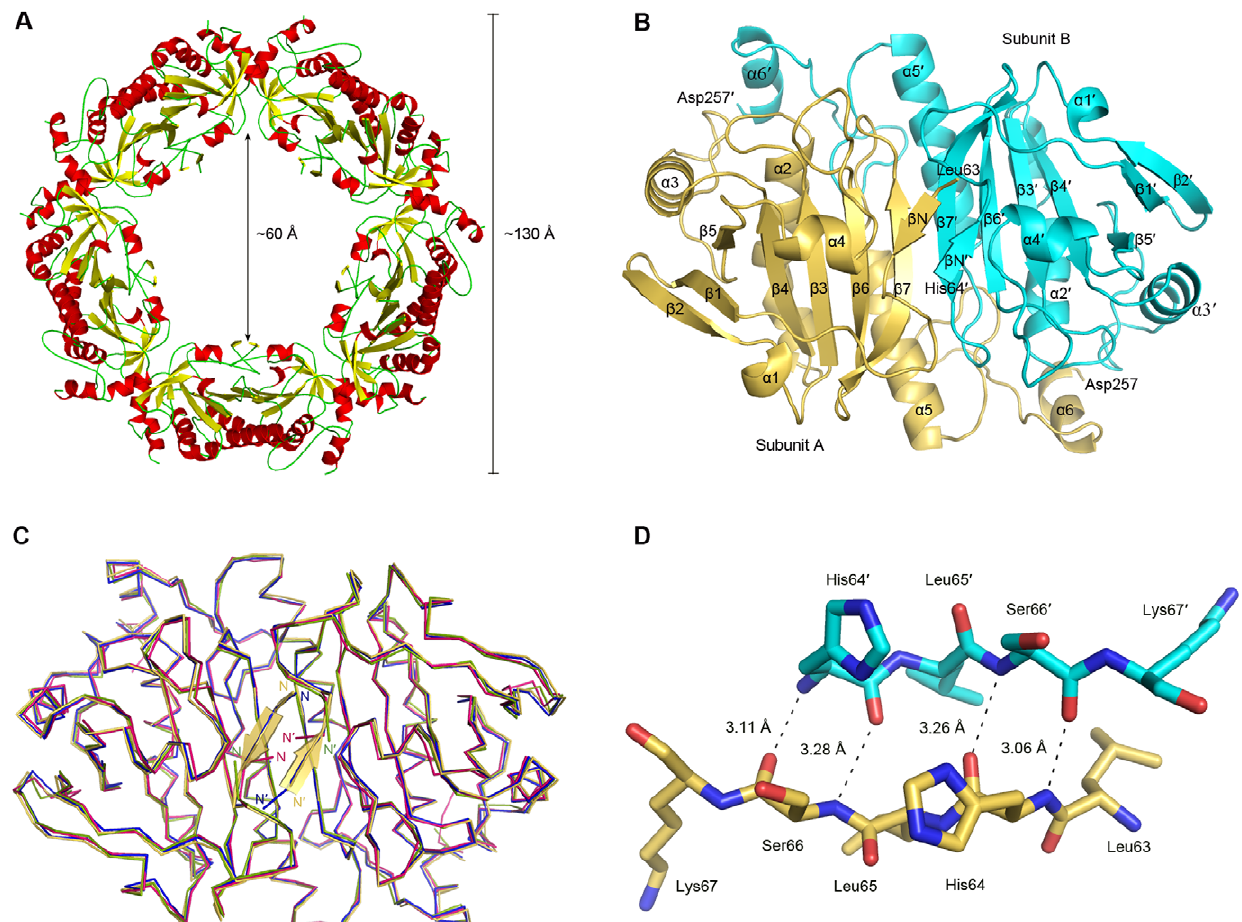
Figure 1. Structure and comparison of P.crocea Prx4. A The homodecameric structure. B The dimeric structure. Subunits A and B are colored in orange and cyan, respectively. All secondary structures are labeled sequentially. C Superposition of P. crocea Prx4 (orange), H. sapiens Prx4 (blue), R. norvegicus Prx1 (hotpink), and T. cruzi TryP (green). D Hydrogen bonds of the antiparallel b -sheet. Atoms N and O are colored in blue and red, respectively, in both subunits. Atom C is colored in orange and cyan in subunit A and B, respectively.